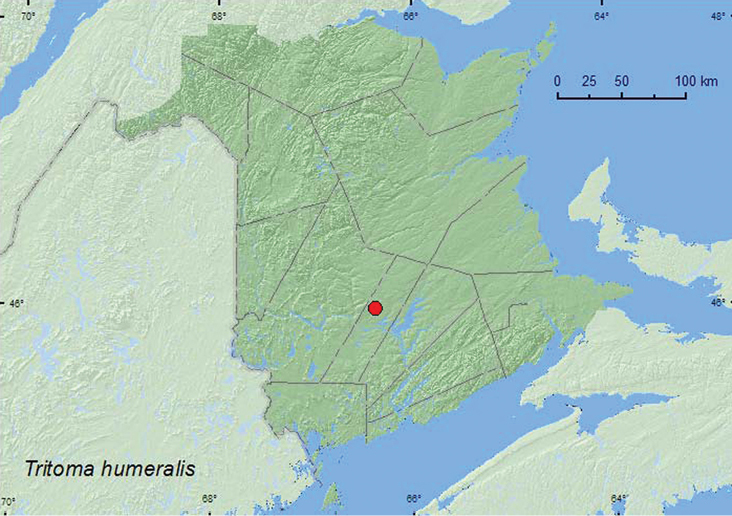
Collection localities in New Brunswick, Canada of Tritoma humeralis.